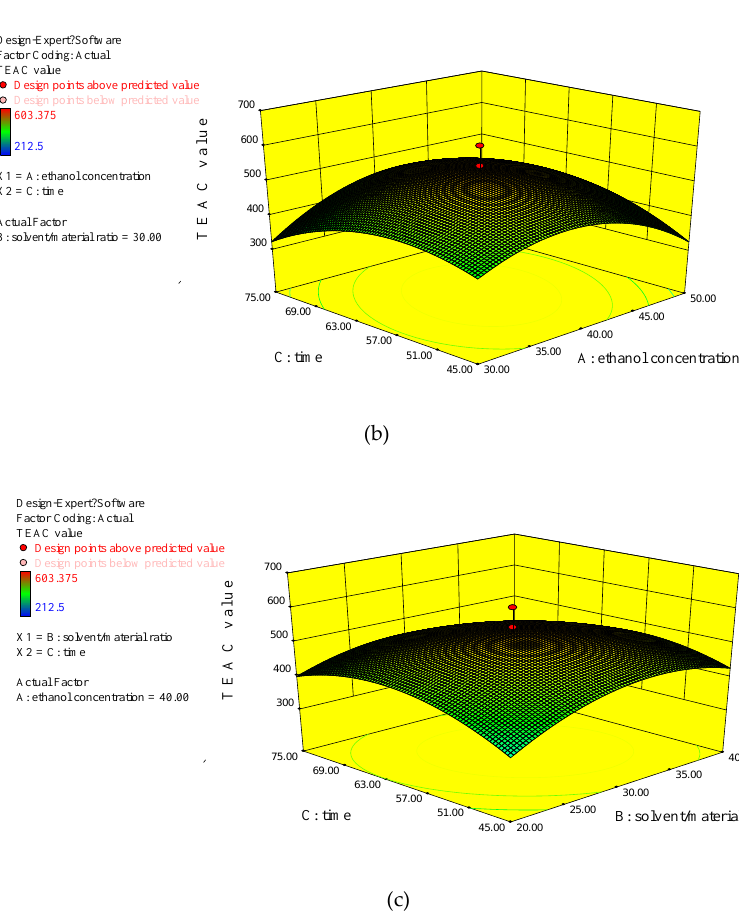
Figure 3. The three-dimensional plots of response surface. ( a ) The combined effects of ethanol concentration and solvent/material ratio (S/M) ratio when the extraction time was fixed at 60 min; ( b ) The interaction between ethanol concentration and extraction time when S/M ratio was fixed at 30 mL/g; ( c ) The combined effect of extraction time and S/M ratio when the ethanol concentration was fixed at 40%. TEAC, Trolox equivalent antioxidant capacity.